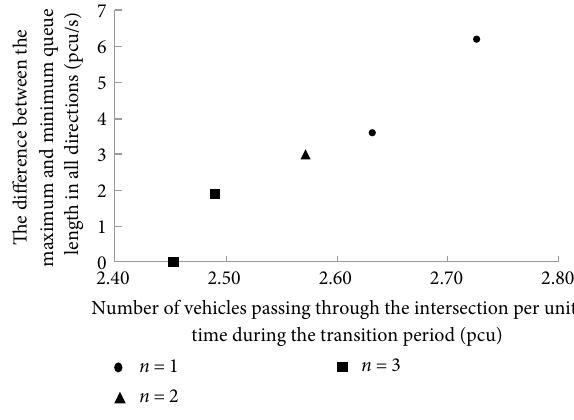
Table 1: Pareto frontier with different n when t